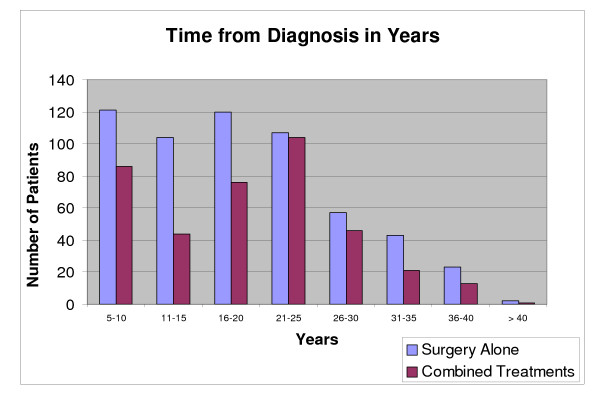
Time from Diagnosis in Years.